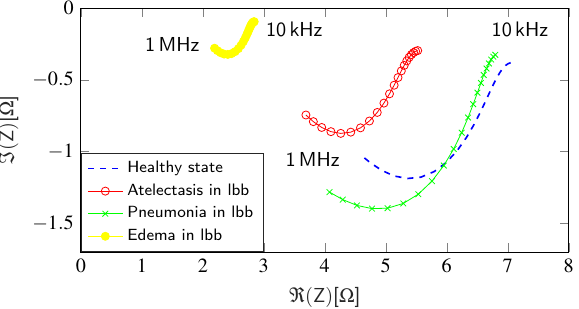
Fig.5: Simulation results for an impedance measurement focused on the left, back, bottom region of the